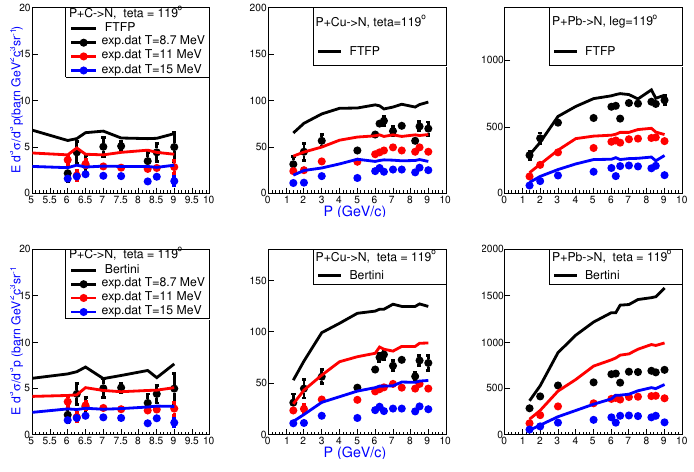
Figure 1. Inclusive cross sections of neutrons produced in pC, pCu, pPb interactions at angle 119 degrees as functions of projectile momenta. Points are experimental data [1]. Lines are calculations by the FTFP model in upper figures, and the Bertini model in bottom figures. Black points and lines correspond to neutrons with energy 8.7 MeV, red points and lines correspond to neutrons with energy 11 MeV, blue points and lines correspond to neutrons with energy 15